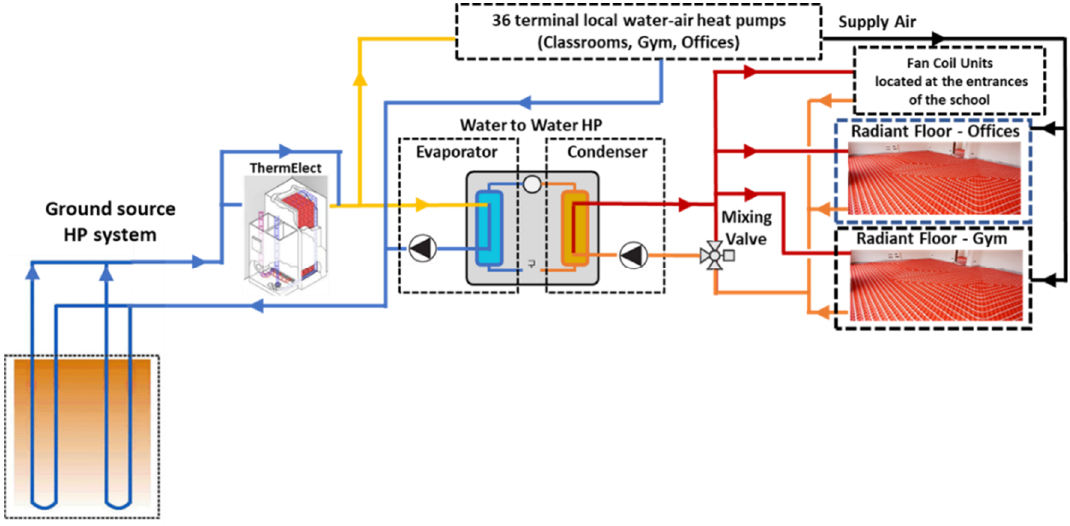
Figure 3. Process flow diagram (PFD) of the building heating systems.